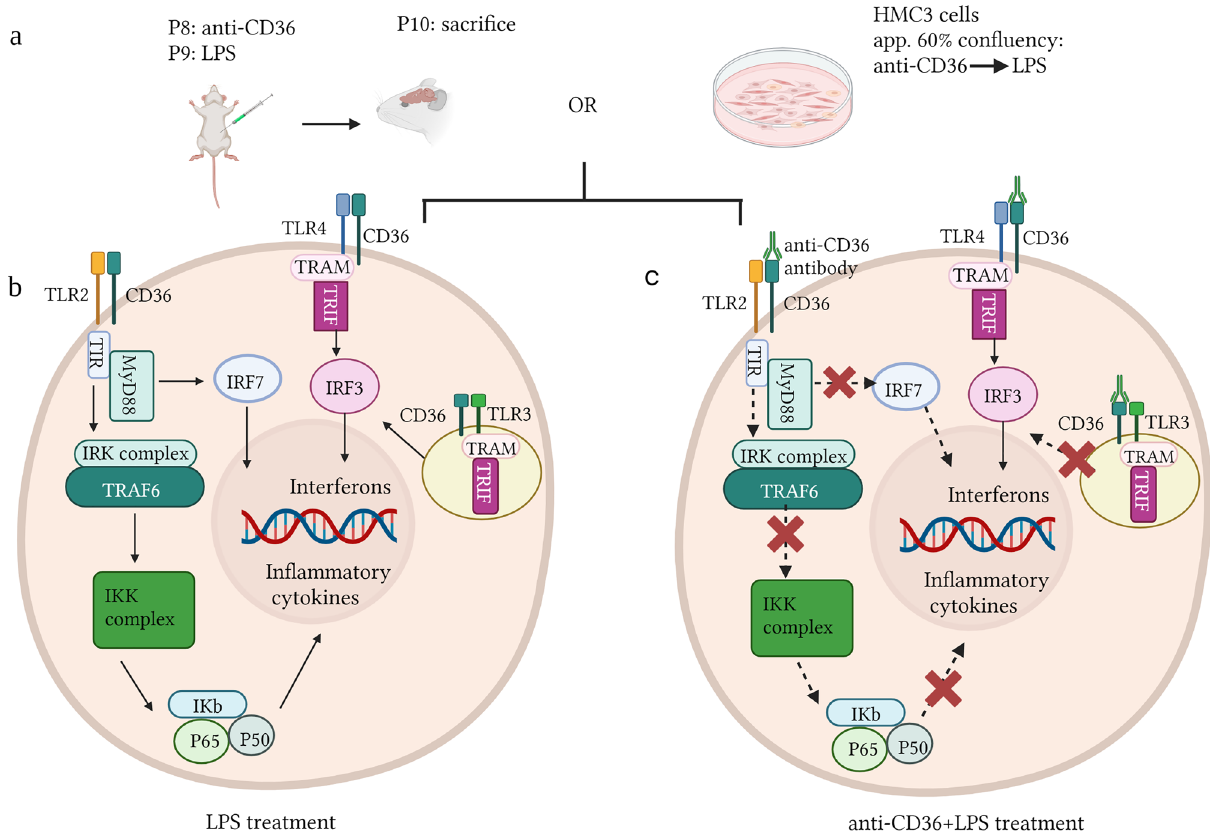
Figure 6. CD36 mediated-effects on TLR signalling pathways in neonatal brain and immature human microglia. A diagram showing the mechanism of the scavenger receptor CD36-TLR mediated signalling in neonatal mouse brain as well as human microglia. ( a ) schematic representation of the methodology used. Neonatal mice and HMC3 cells were treated with LPS or anti-CD36 + LPS. ( b ) Upon activation by various ligands, the TLR2-CD36 mediated MyD88 dependent pathway activates transcription of various inflammatory cytokines. Activated endosomal TLR3 activates IRF3, which promotes transcription of the genes related